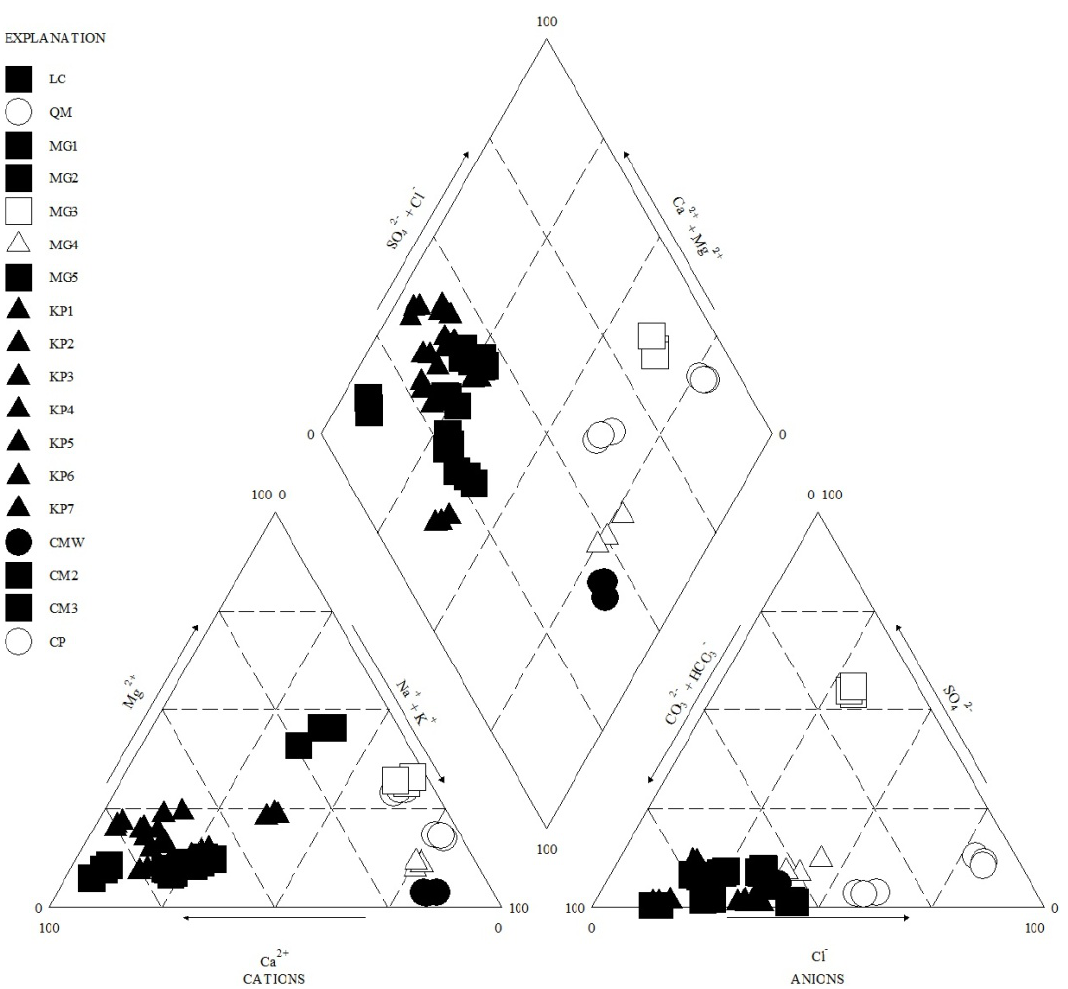
Figure 5. Piper plot of the groundwater samples of Kapas Island (for the months